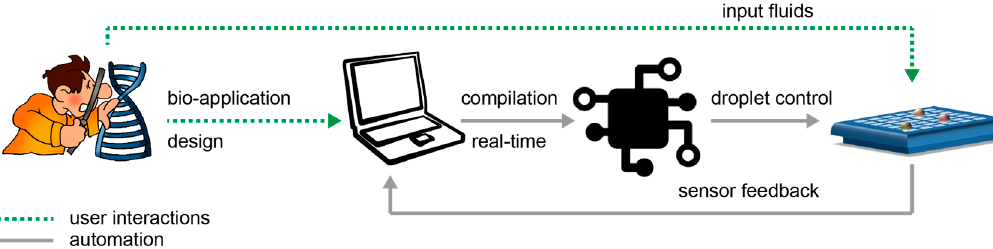
Figure 2. System setup. The user actions are marked with dashed lines and the automated actions are marked with solid lines. The user designs the application on the computer and then loads the microfluidic machine with the input fluids (i.e., samples, reagents, buffers). On the computer, the dedicated software compiles the application to automatically control the movement of the droplets. When the application finishes, the feedback from the sensors is recorded by the computer and transformed into data to be further read and analyzed by the user.